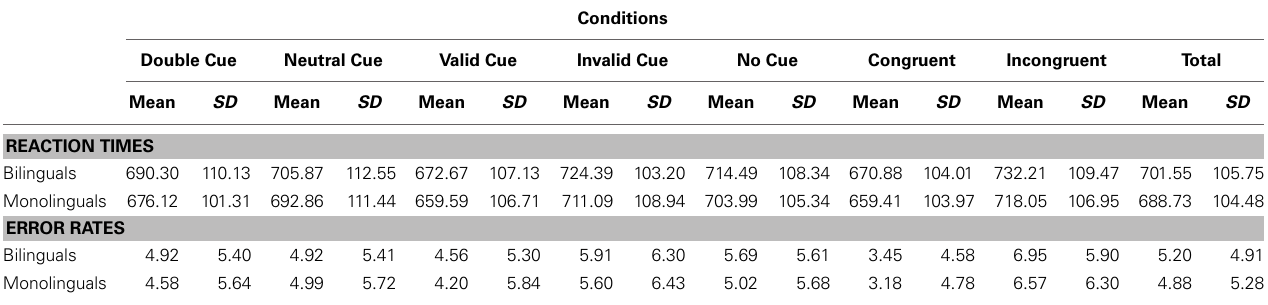
Table 2 | Reaction times and error rates to each condition.